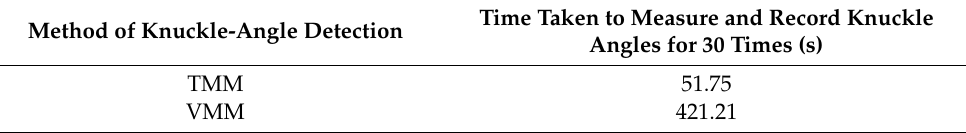
Table 5. Time taken to measure and record data for 30 joint angles under different